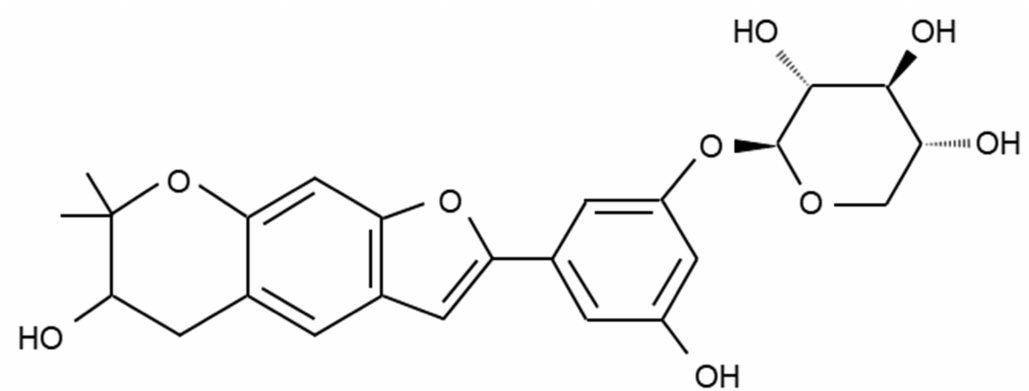
Figure 1. Chemical structure of mulberroside C (MW. 458.46) isolated from M.